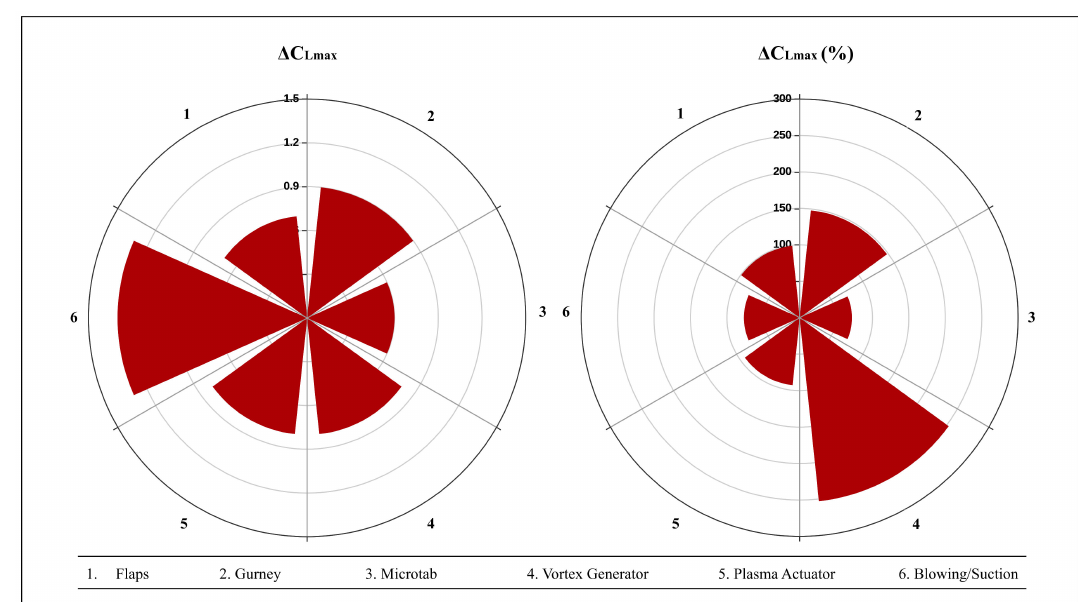
Figure 13. Maximum lift-enhancement ∆ C Lmax and relative enhancement %C Lmax of the reviewed flow-control